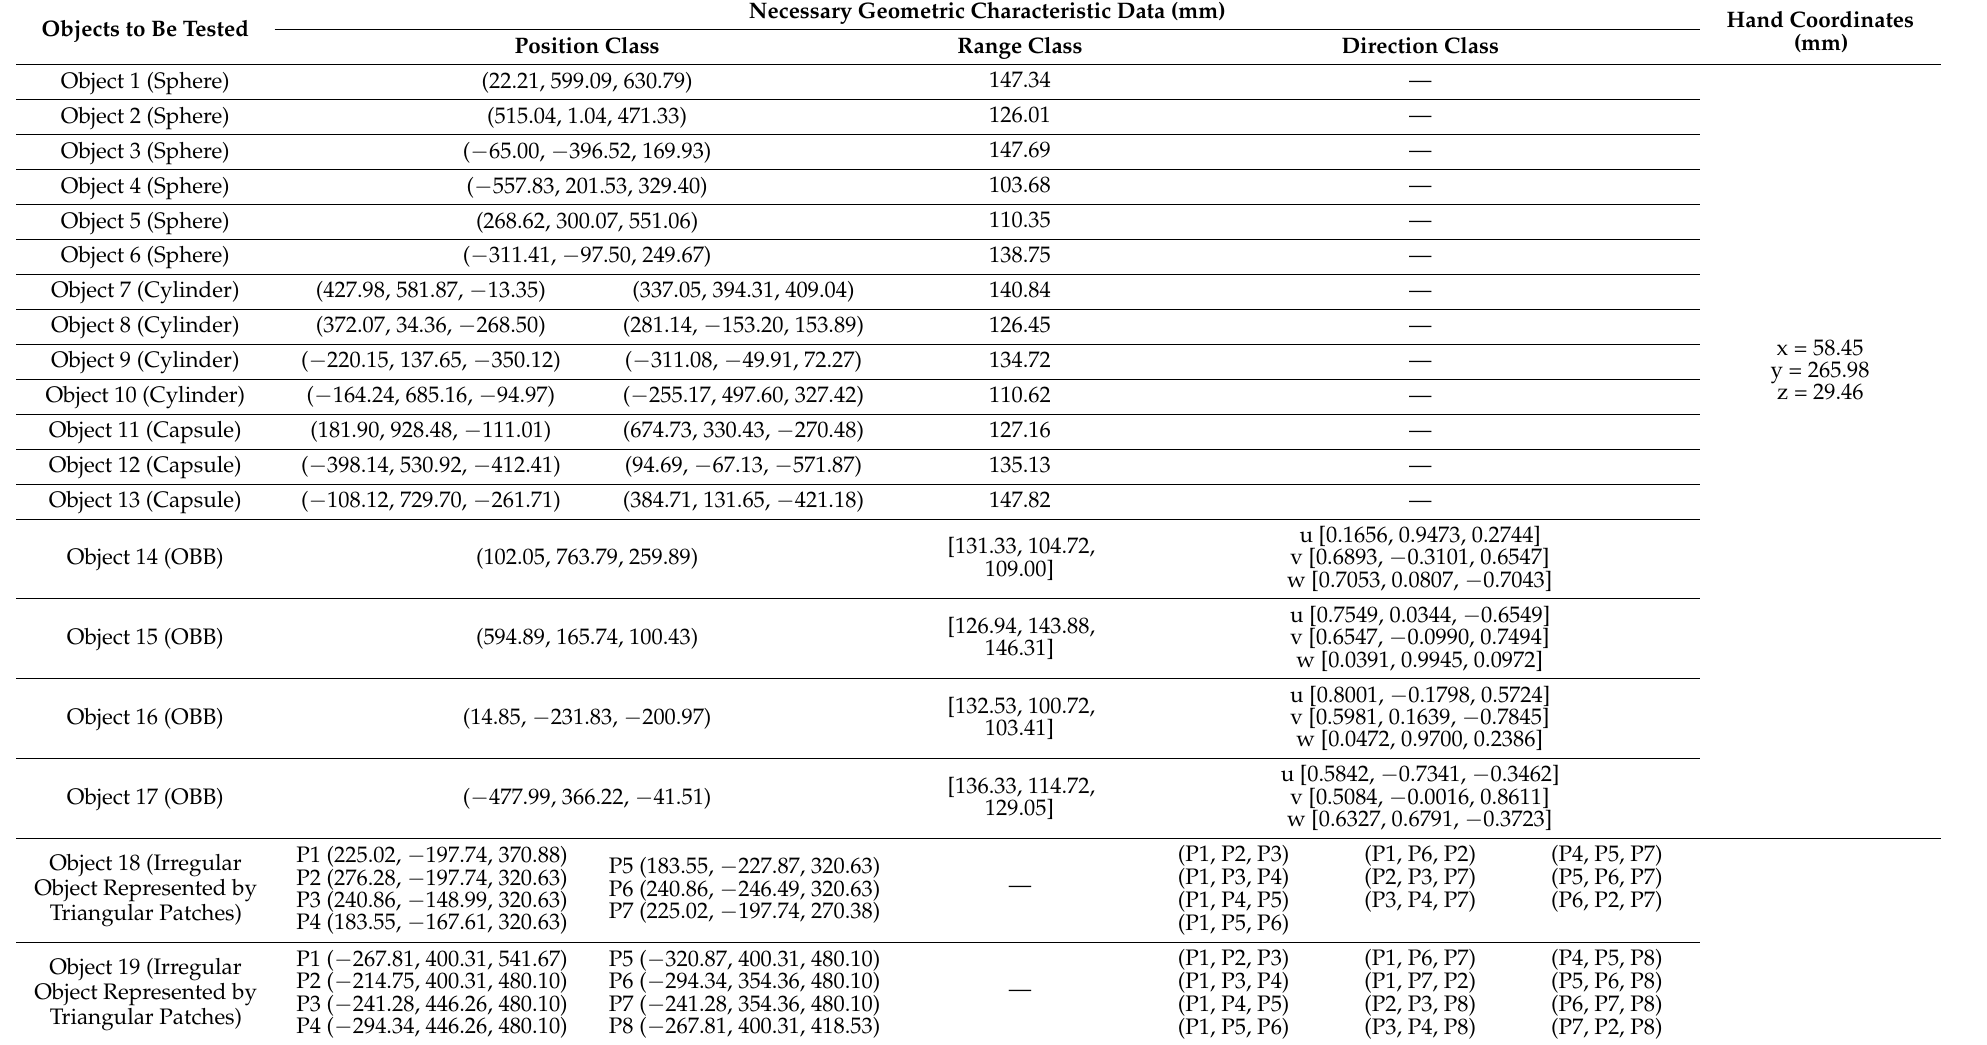
Table 6. Necessary Geometric Characteristic Data of the Object in Scene